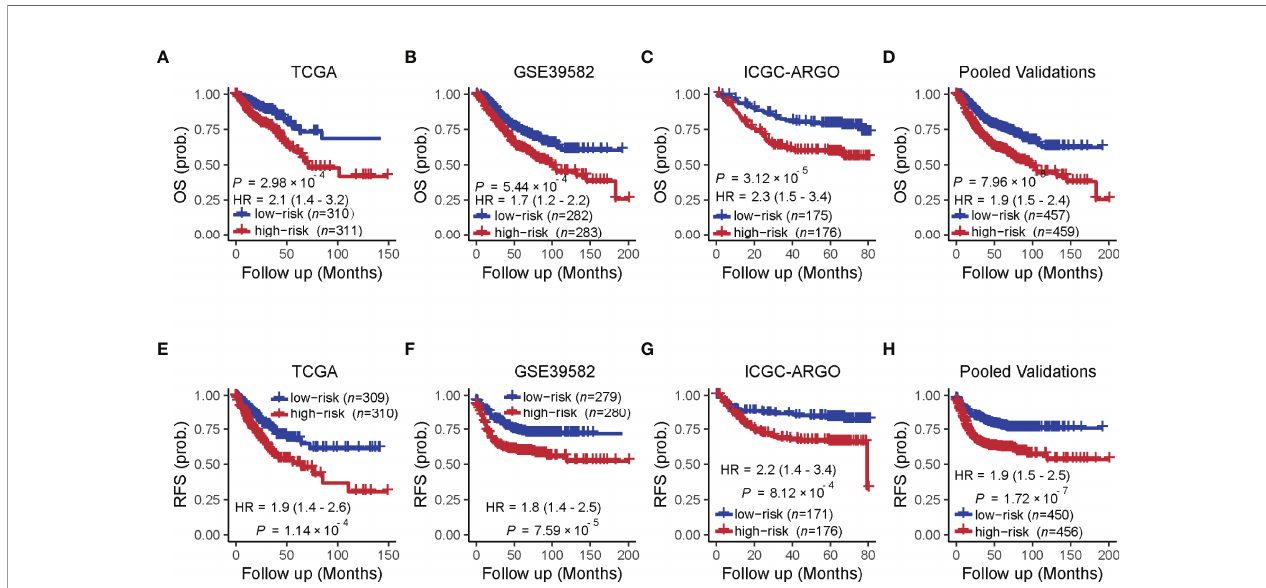
FIGURE 3 | Prognostic value of the TF-9 for colorectal cancer. (A) Kaplan – Meier survival analysis showed that the high-risk group had worse overall survival than the low-risk group in the training cohort (TCGA). (B, C) In the two independent validation cohorts and (D) the pooled cohorts, the high-risk group also showed a signi fi cantly poor prognosis for overall survival. (E – H) The training cohort, the two independent validation cohorts, and the pooled validation cohort demonstrated that the high-risk group showed a signi fi cantly poor prognosis for recurrence-free survival. P-values were calculated by log-rank tests. “ OS ” refers to overall survival; “ RFS ” refers to recurrence-free